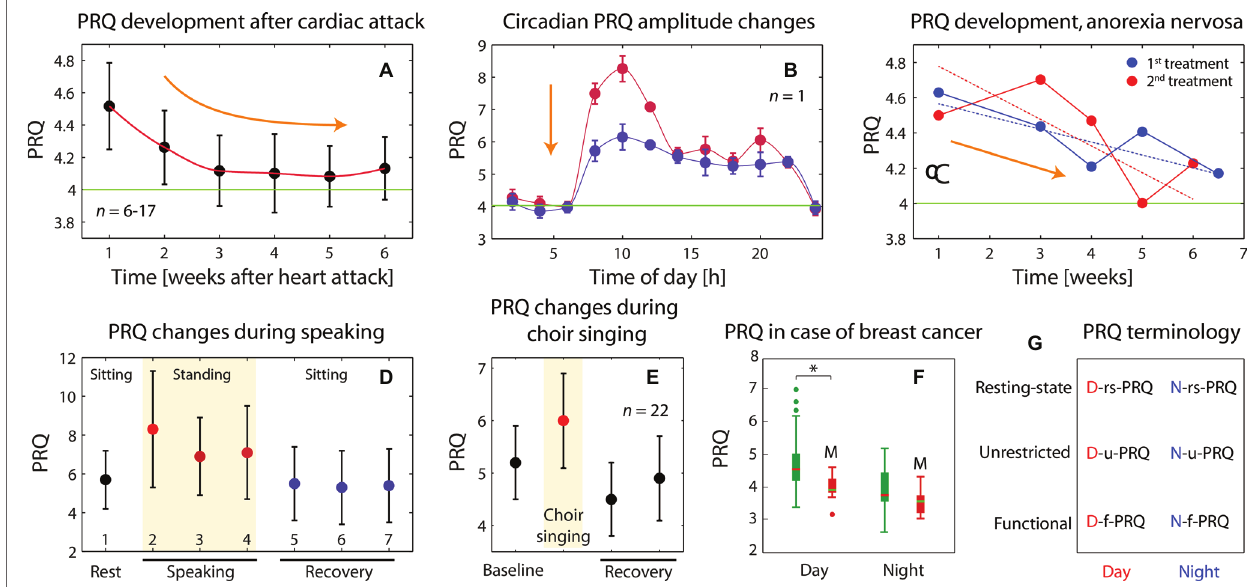
FIGURE 4 | (A) Dependence of nightly resting-state PRQ (N-rs-PRQ) values as a function of time after a cardiac attack ( n = 6–17, dependent on data point, mean ± standard error of the mean; data extracted from Kümmell and Heckmann, 1987). The PRQ normalization toward 4:1 is evident during the recovery phase after the incident. (B) The effect of a health intervention [12 spa (balneology) treatments] on the circadian PRQ oscillation amplitude is shown exemplarily for one subject. A less pronounced morning and evening PRQ peak is visible, indicating a normalization of the physiological state. Mean and standard error of the mean values are shown based on averages over 3 days. It was not possible to infer from the publication whether the PRQ values represent rs-PRQ or u-PRQ. Data extracted from Hildebrandt (1955). (C) N-rs-PRQ values for one subject (female) with anorexia nervosa that obtained two treatment periods (red and blue curves) over several weeks. Data extracted from Heckmann et al. (1990). The PRQ values represent monthly daily resting-state PRQ (D-rs-PRQ) values. A clear trend of PRQ normalization toward 4:1 is visible during the course of the treatments. (D) Changes of functional PRQ (f-PRQ) values during an experiment with three types